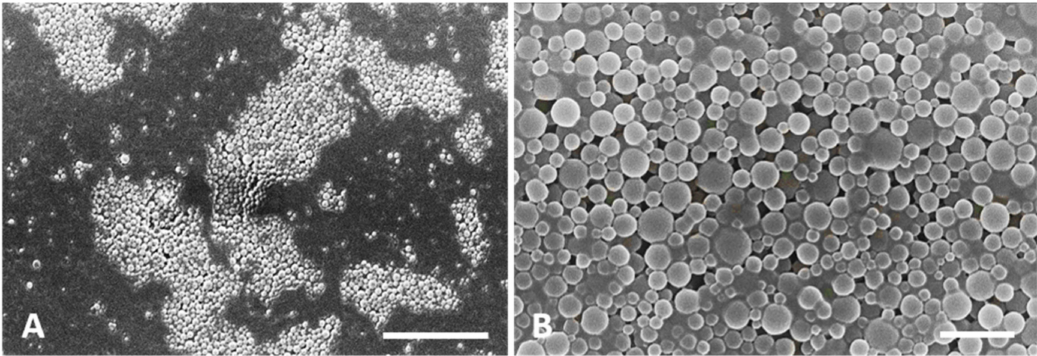
Figure 2. SEM micrographs of double-coated NPs. ( A ) Empty NPs. ( B ) Insulin-loaded NPs. Note in both cases the well-defined NPs spherical shape. Scale bars = 5 µ